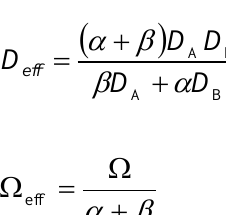
and effective diffusivity of mass-transport D 2